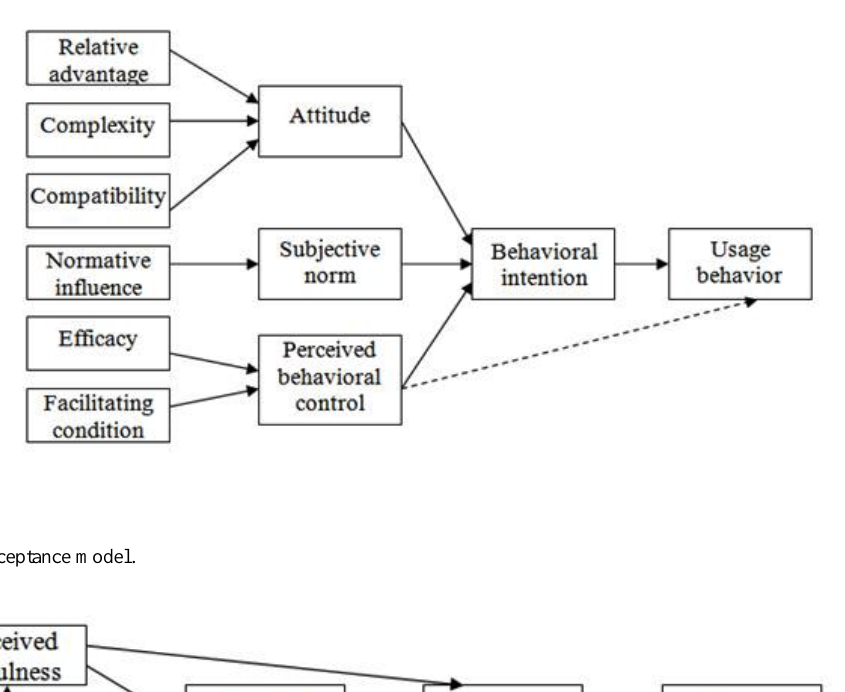
Figure 2. Theory of planned behavior.